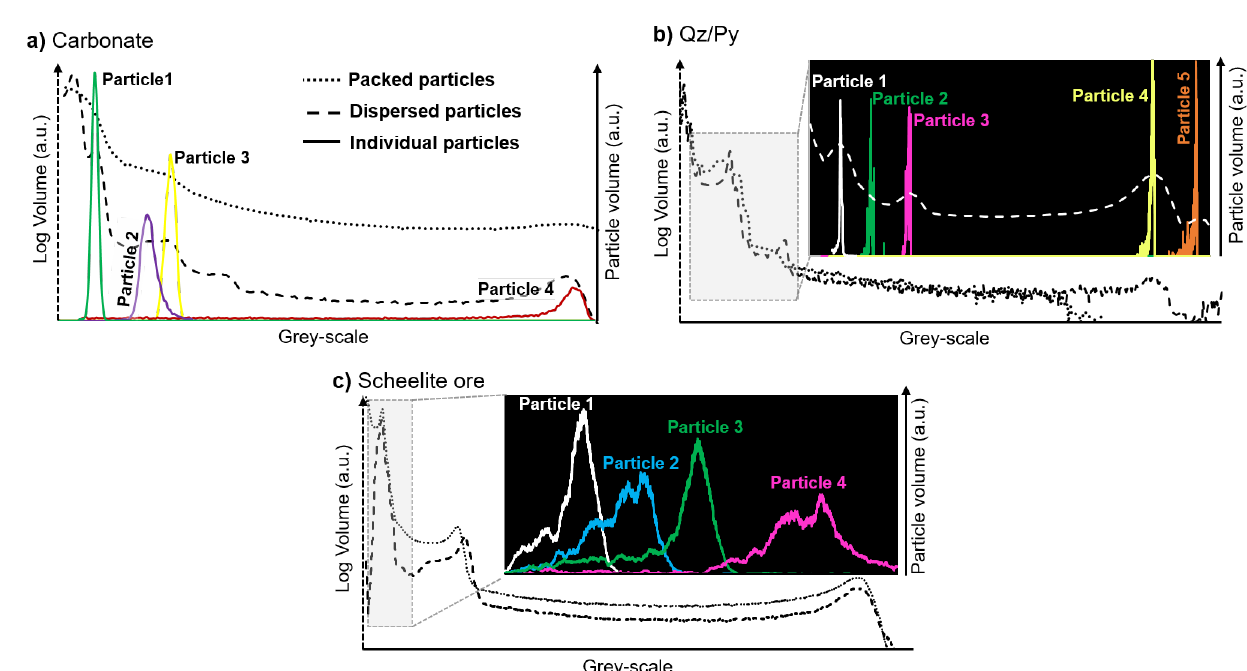
Figure 3. Comparison of the histogram of 3D images corresponding to samples of the same material but scanned without sample preparation as packed particles (dotted line) and prepared as particle dispersions (dashed line), and the histogram of individual particles obtained by applying MSPaCMAn (continuous lines, each color corresponds to a different particle). The three types of materials are shown ( a – c ).